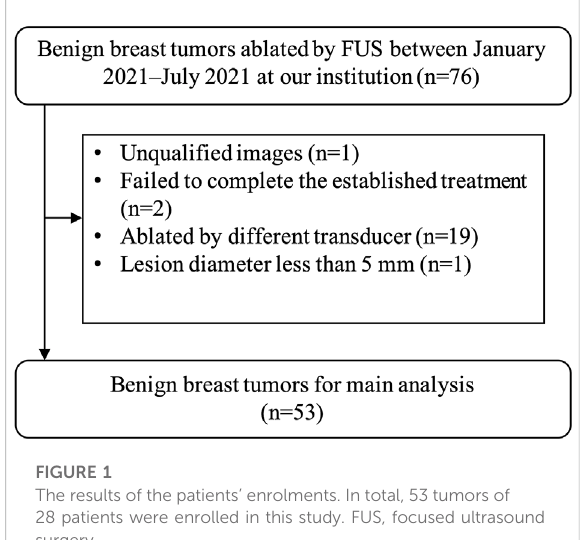
FIGURE 1 The results of the patients ’ enrolments. In total, 53 tumors of 28 patients were enrolled in this study. FUS, focused ultrasound